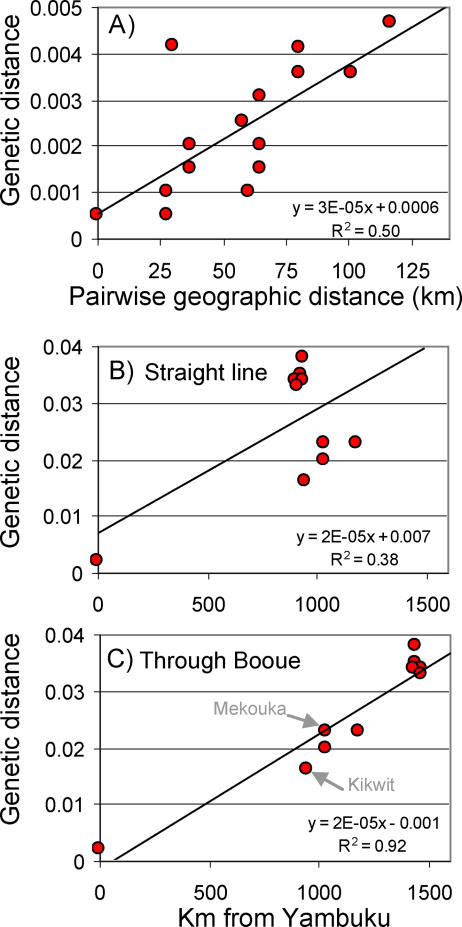
Correlation between Geographic Distance and Patristic Genetic Distance(A) ML genetic distances (substitutions per nucleotide site) plotted as function of geographic distance separating pairs of outbreak sites for the six full-length, georeferenced sequences sampled by Leroy et al. (R2 = 0.70, Mantel test p = 0.002). Makokou and Yembelengoye sequences excluded because of unknown spatial origin of case and partial sequence, respectively (Protocol S3).(B) Correlation between straight line distance from the initial ZEBOV outbreak site at Yambuku and patristic genetic distance to Yambuku for all available georeferenced, full-length sequences (R2 = 0.38 , n = 11, p = 0.040).(C) Same as (B) but with geographic distances to the recent Gabon-Congo border outbreaks measured as passing through Booué (R2 = 0.92 , n = 11, p < 0.001).